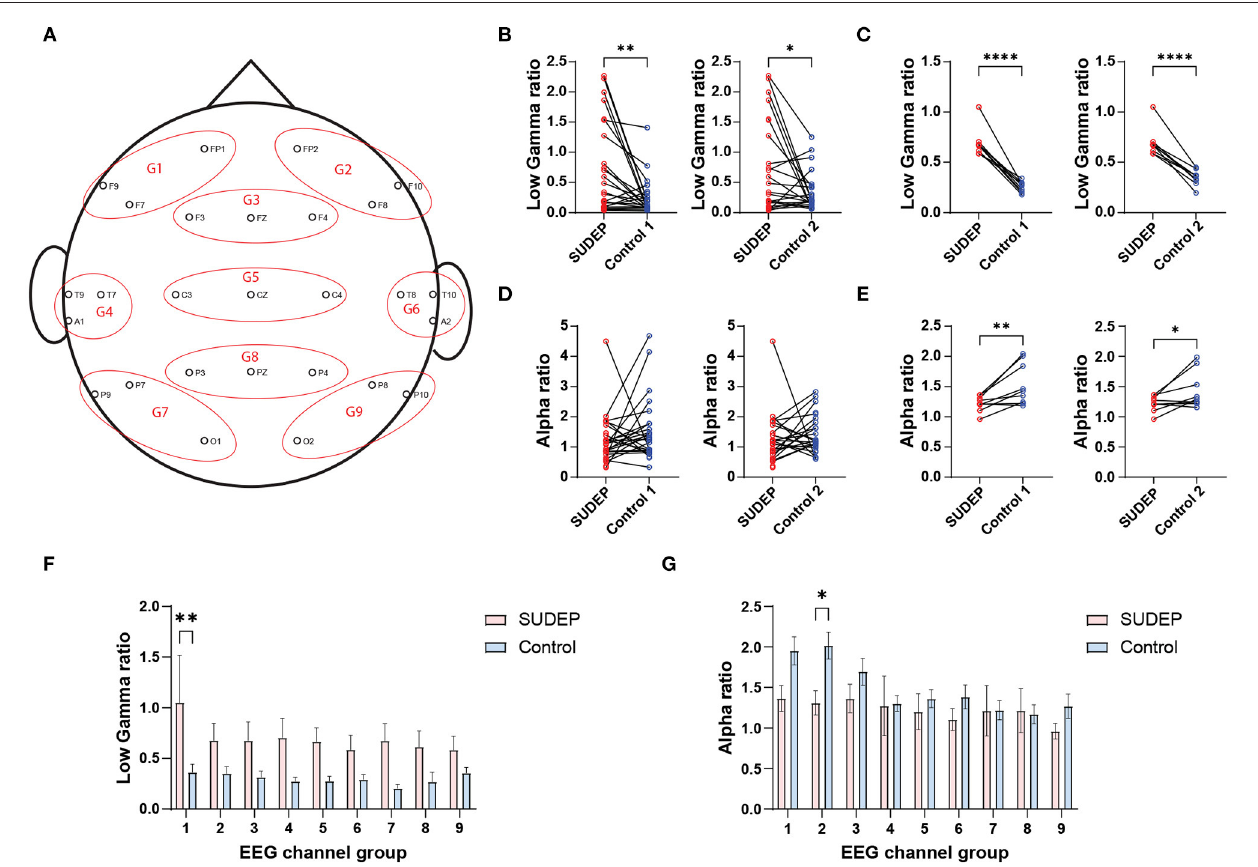
FIGURE 1 | (A) Clustering scalp electroencephalography (EEG) electrodes (10–20 International System) into nine channel groups (G1–G9). (B) Comparison of channel-averaged EEG low gamma sleep/wake power ratios between SUDEP Patients and age-matched living epilepsy controls (SUDEP vs. control 1, ** p = 0.0033, paired t -test; SUDEP vs. control 2, * p = 0.0251). (C) Comparison of subject-averaged EEG low gamma sleep/wake power ratios between SUDEP patients and age-matched living epilepsy controls (****, p < 0.0001, paired t -test). (D,E) Similar to panels (B,C) except for the alpha band [panel (D) : n.s., p = 0.258 and p = 0.719; panel (E) : ** p = 0.009 and * p = 0.039, paired t -test]. (F) Comparison of EEG low gamma sleep/wake power ratios between SUDEP patients and age-matched controls in nine EEG channel groups (**, p = 0.0012, two-way ANOVA test; error bar denotes SEM). (G) Similar to panel F, except for the alpha band (**, p = 0.048, two-way ANOVA